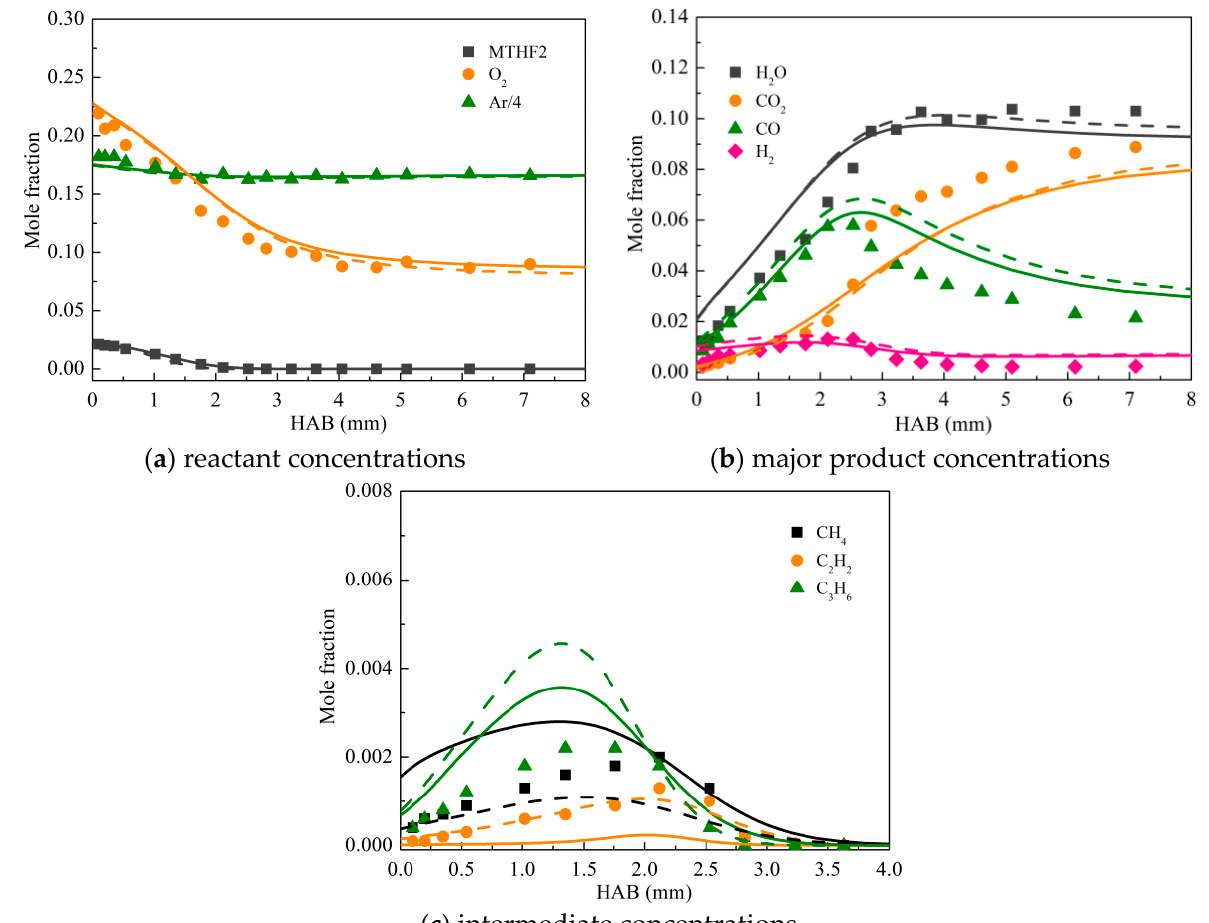
Figure 10. Measured (symbols) [16] and calculated (lines) species concentrations in premixed MTHF2 flames at φ = 0.7. Solid lines: reduced diesel/MTHF2 mechanism; dashed lines: detailed MTHF2 mechanism [17].